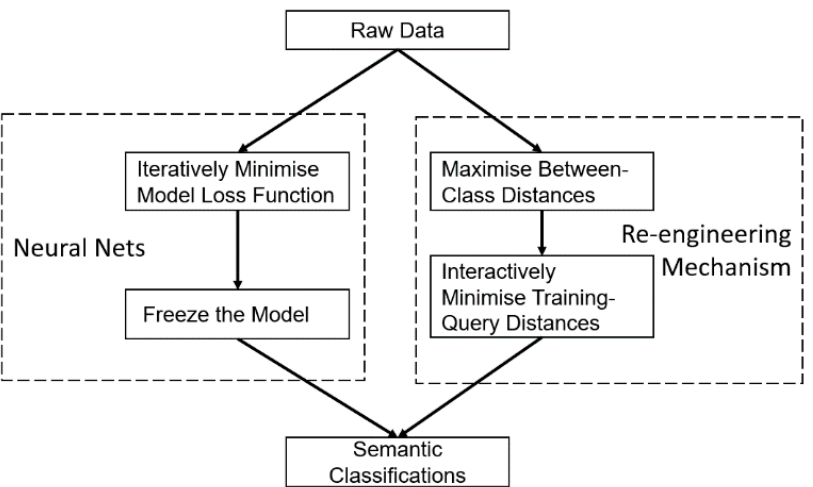
Figure 7. System flowchart diagram of the comparison between the neural nets and the proposed re-engineering framework for embedding feature generation. The system adaptively re-engineers the word embeddings for each given query sample to provide the best possible match, as opposed to fitting different query samples with a static model.